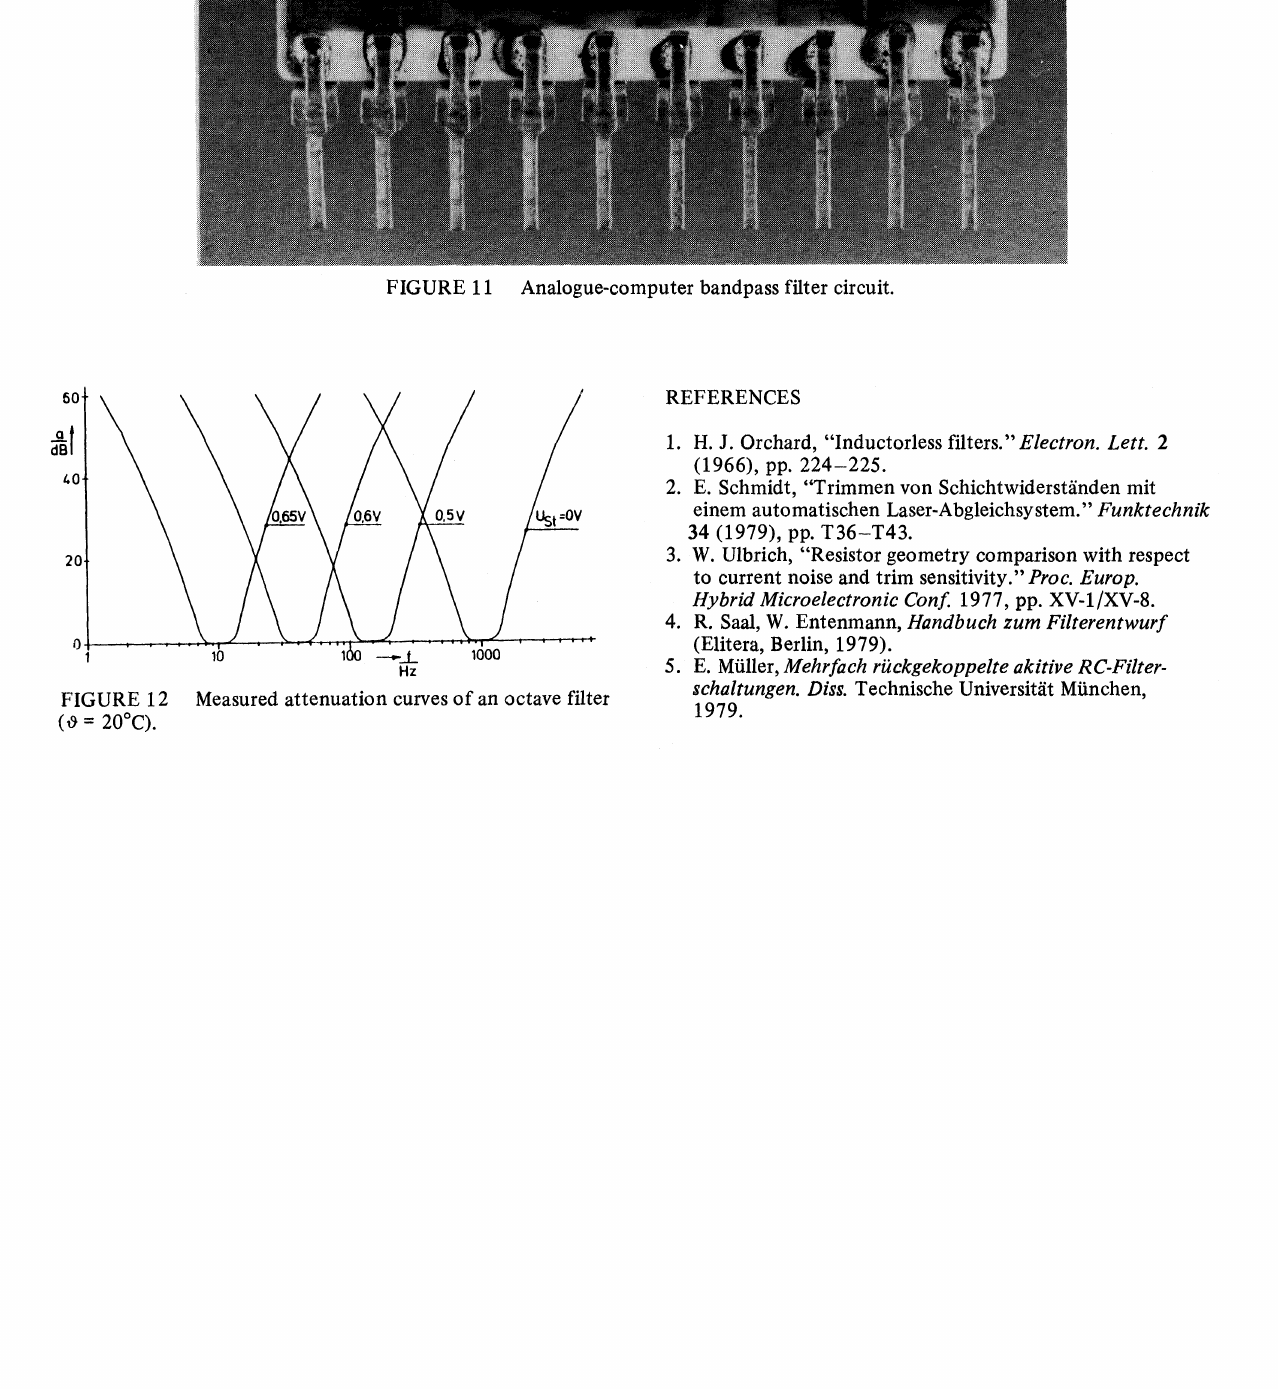
FIGURE 11 Analogue-computer bandpass filter